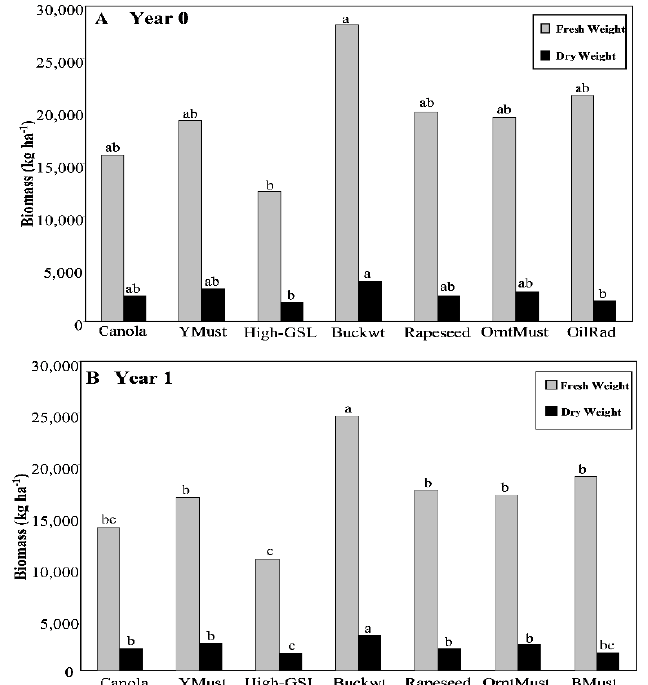
Figure 2. Fresh and dried weights of rotation crop biomass from the Northern Aroostook site in ( A ) Year 0 and ( B ) Year 1 immediately prior to incorporation. Values were derived from 1/8 m 2 quadrat samples. Means for each sample type (fresh or dry) for each year with the same letter are not significantly different according to Fisher’s protected LSD at P = 0.05.